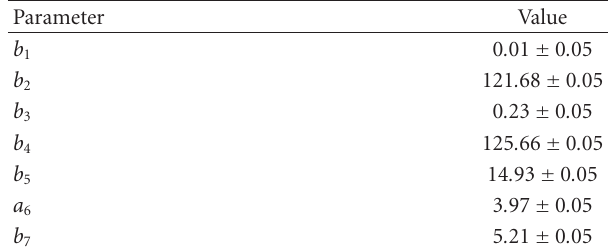
Table 4: Values of the relevant parameters found for the best agreement between simulated and experimental data for the fission of 208 Pb induced by 500 MeV protons. Errors indicated represent superior limit for